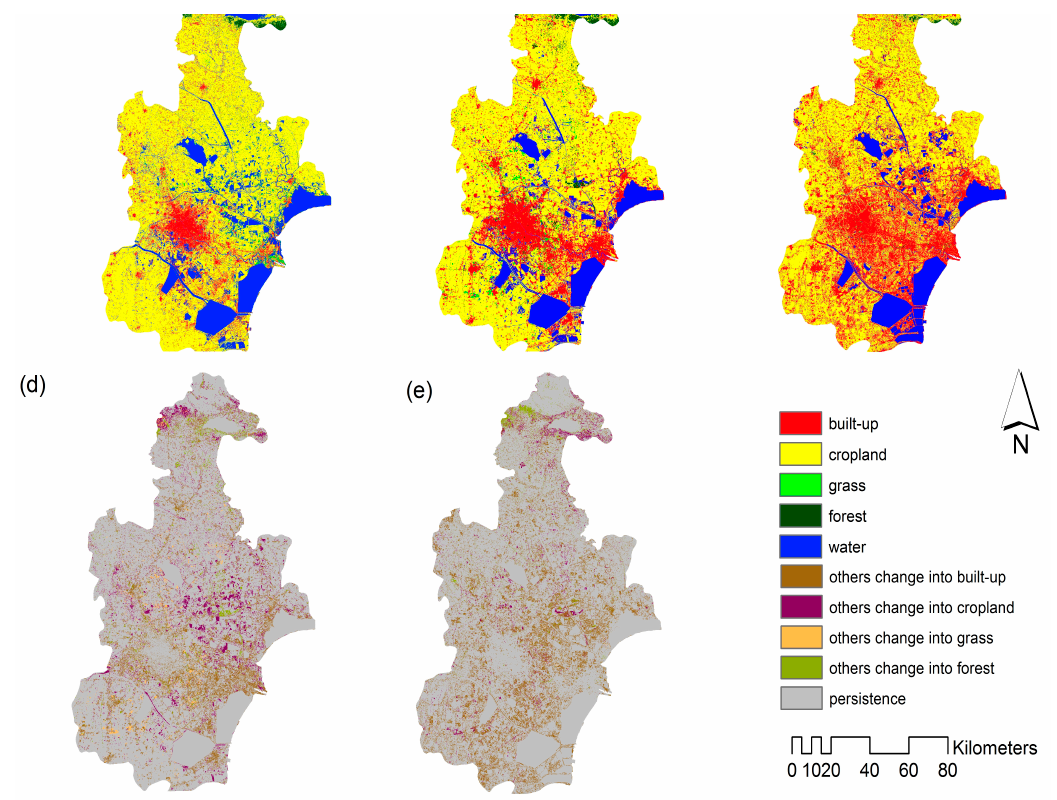
Figure 4. Land use and land cover (LULC) in 1995 ( a ), 2005( b ), 2015( c ), change map from 1995–2005 ( d ), and change map 2005–2015 ( e ). Table 2. LULC classification